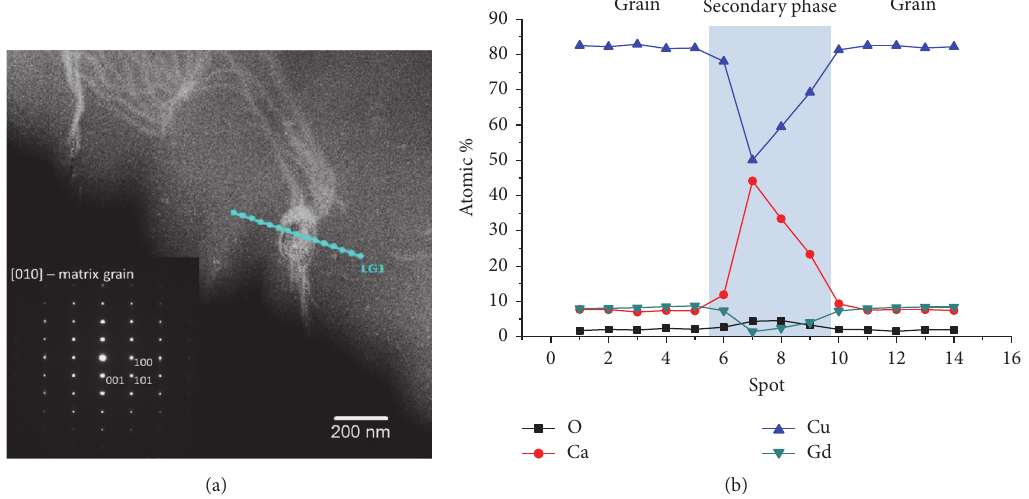
Figure 3: (a) Cross section image in STEM mode of a Cu 5 Gd 0.5 Ca 0.5 melt-spun ribbon showing that the matrix grains have hexagonal symmetry (SAED). Also, a negligible amount of secondary Cu-Ca phase was found; (b) EDS line scan (14 points) confirmed stoichiometric, that is, nominal, composition of the matrix phase, low oxygen level, and segregation of Cu-Ca